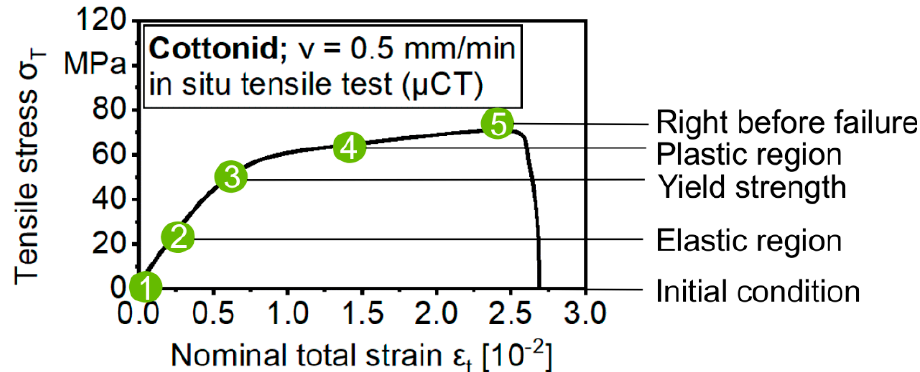
Figure 4. Determination of significant regions in the stress–strain behavior of Cottonid to visualize damage development on the surface and in the volume.